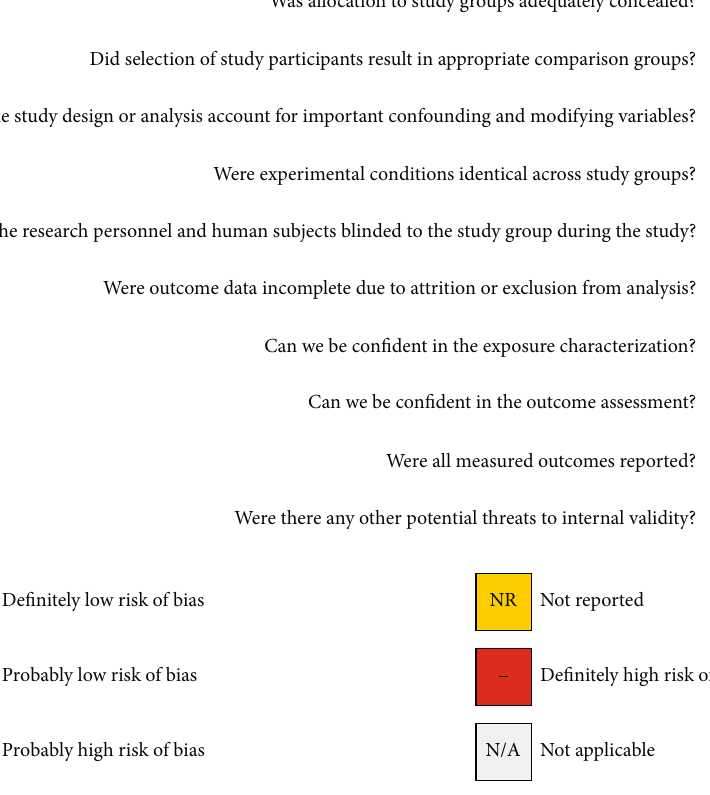
Figure 2: An assessment of the risk of bias among animal